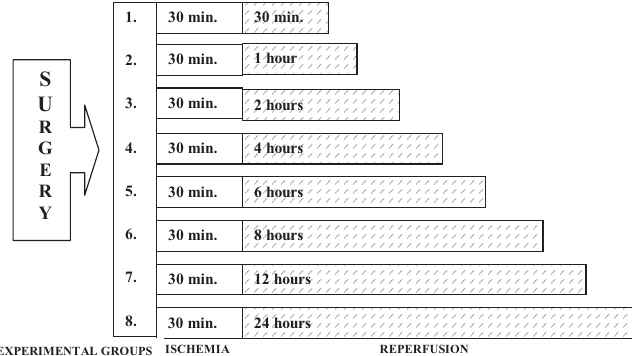
FIgURE 2 - The experimental protocol for investigating apoptosis by different duration of reperfusion after surgery and 30-minute